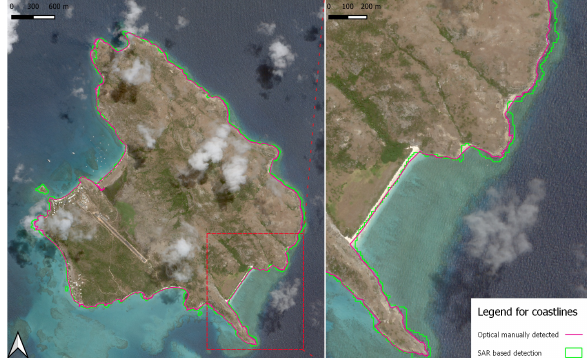
Figure 9. The SAR based detected coastline (in green) extracted with the process explained in Section 2.1 is compared to the manually digitized coastline (in green) based on the optical imagery Planet SkySat (0.8 m pixel spacing), by ©Planet Labs Inc. On the right there is an enlarged view to appreciate finer